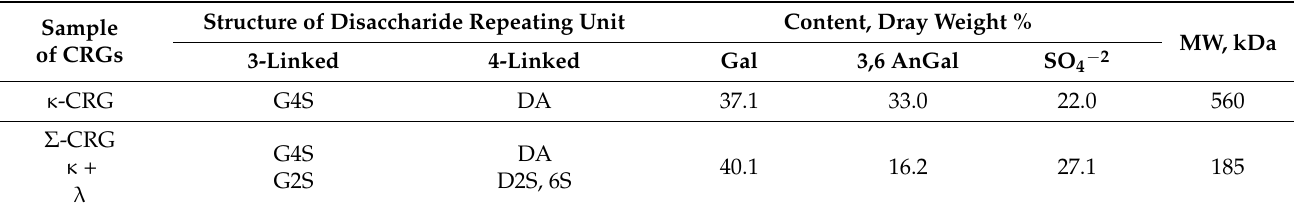
Table 1. Characteristics of CRGs from Chondrus armatus .